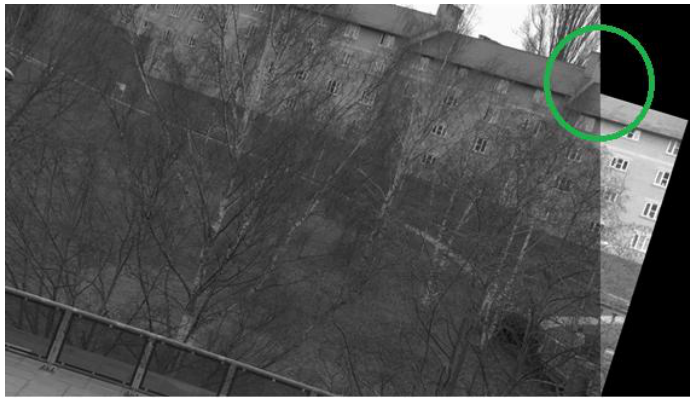
Figure 14. Image registration result for the image pair 7 of the database using IBR alone. The region inside the green circle shows good registration.